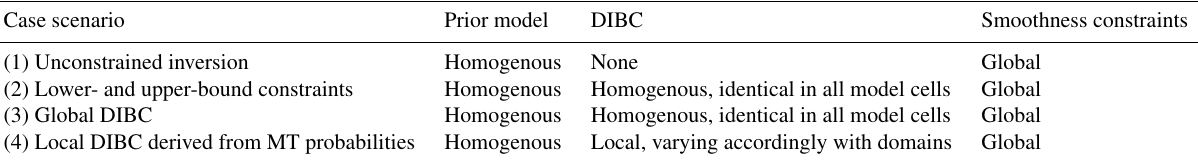
Table 4. Scenarios tested for the utilisation of MT-derived information in the field case and corresponding α weights used in the